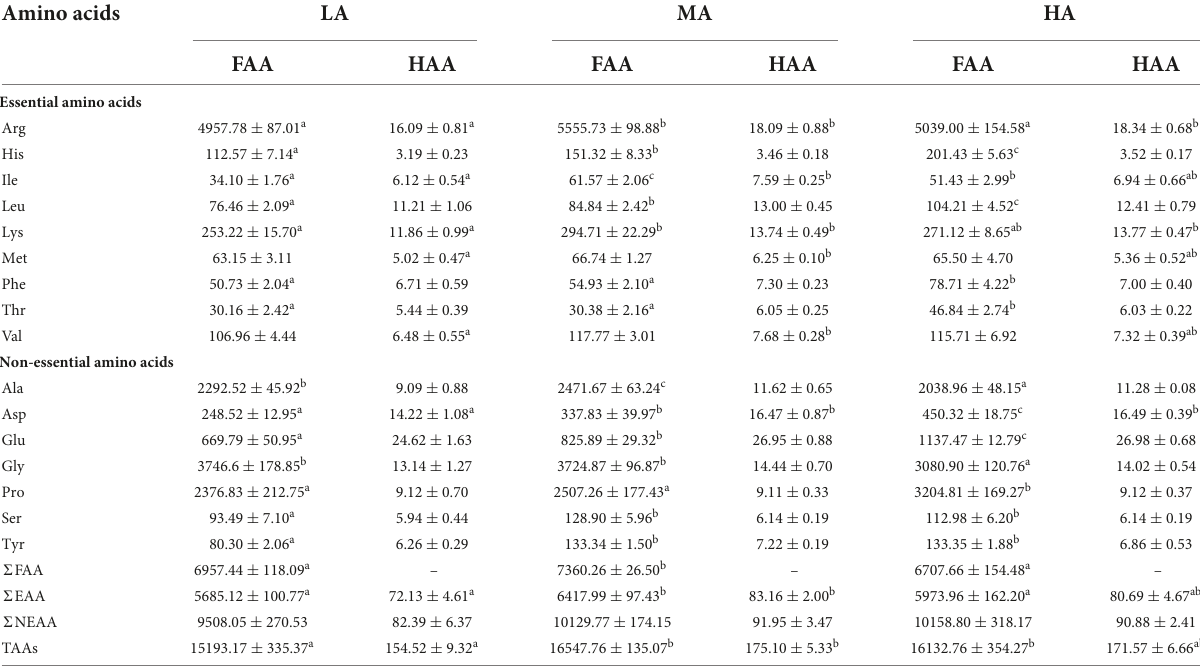
TABLE 3 Free amino acid (mg kg − 1 ) and hydrolyzed amino acid (g kg − 1 ) contents in the muscle of L. vannamei after dietary arginine treatment for 56 days. Amino acids